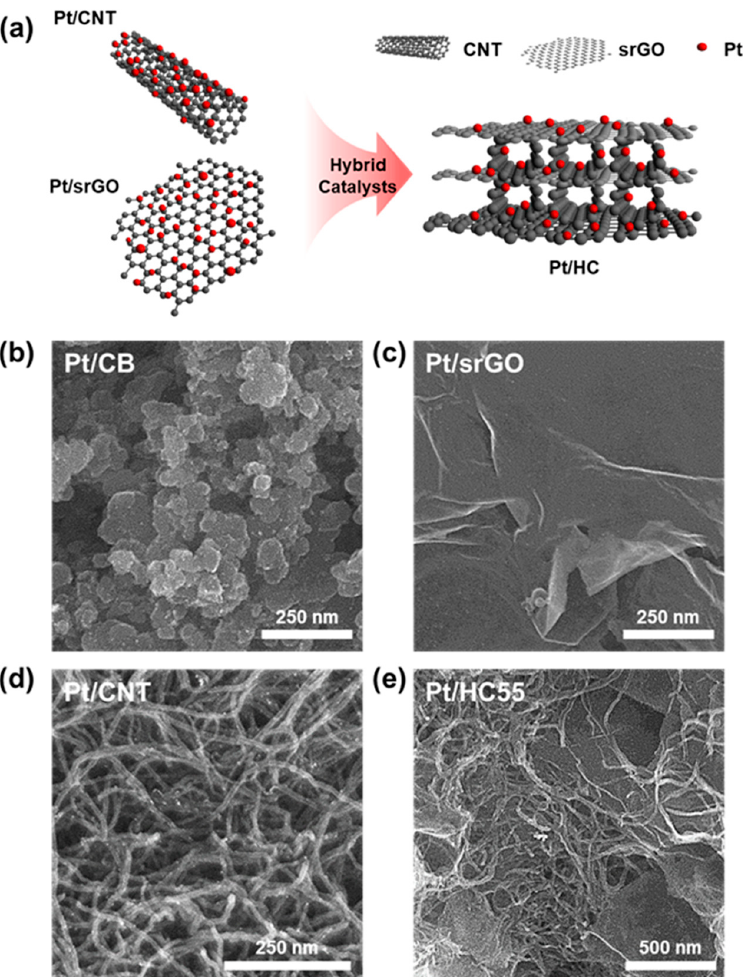
Figure 1. ( a ) Schematic of synthesis of ORR hybrid catalysts. SEM images of ( b ) Pt/CB, ( c ) Pt/srGO, ( d ) Pt/CNTs, and ( e ) Pt/HC55.